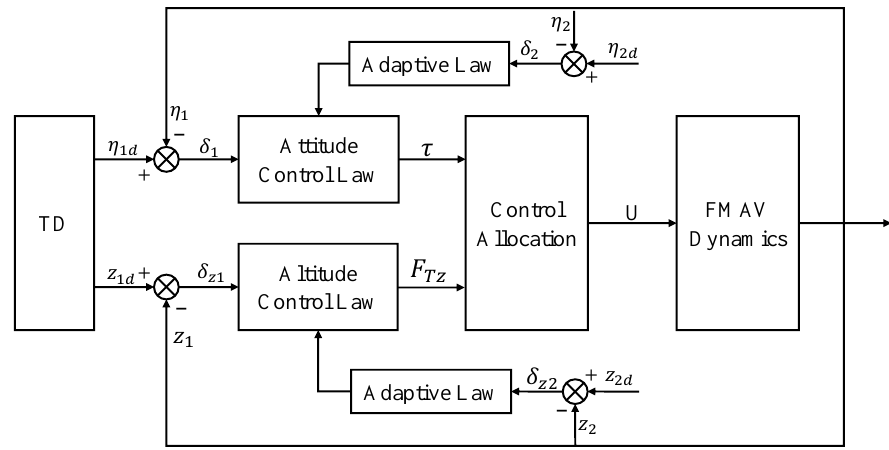
Figure 6. The block diagram of the attitude and altitude